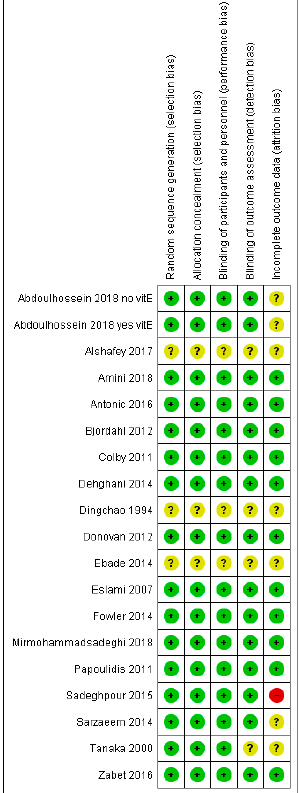
Figure 2. Risk of bias summary. Review authors’ judgments about each risk of bias item for each included trial. A plus mark (+) indicates that there is no substantial concern for bias in the particular quality item. A question mark (?) indicates that conclusions are unable to be drawn regarding potential